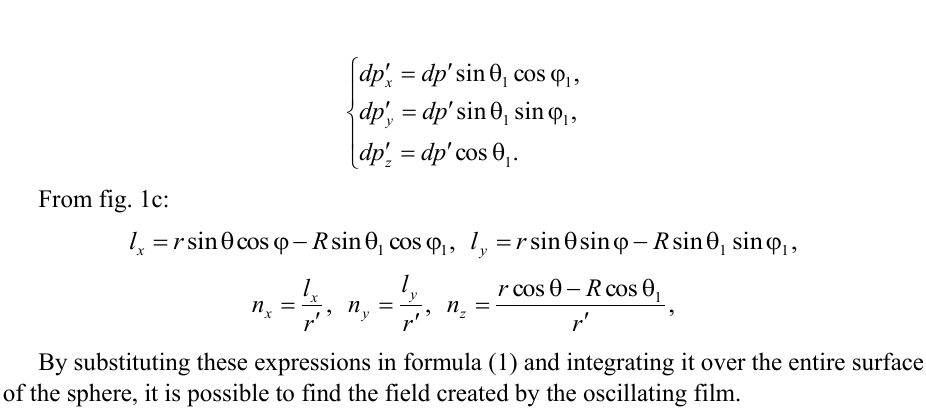
Fig. 2. Field intensity of the film at a distance 1  r mm, 2/  rad (1 –